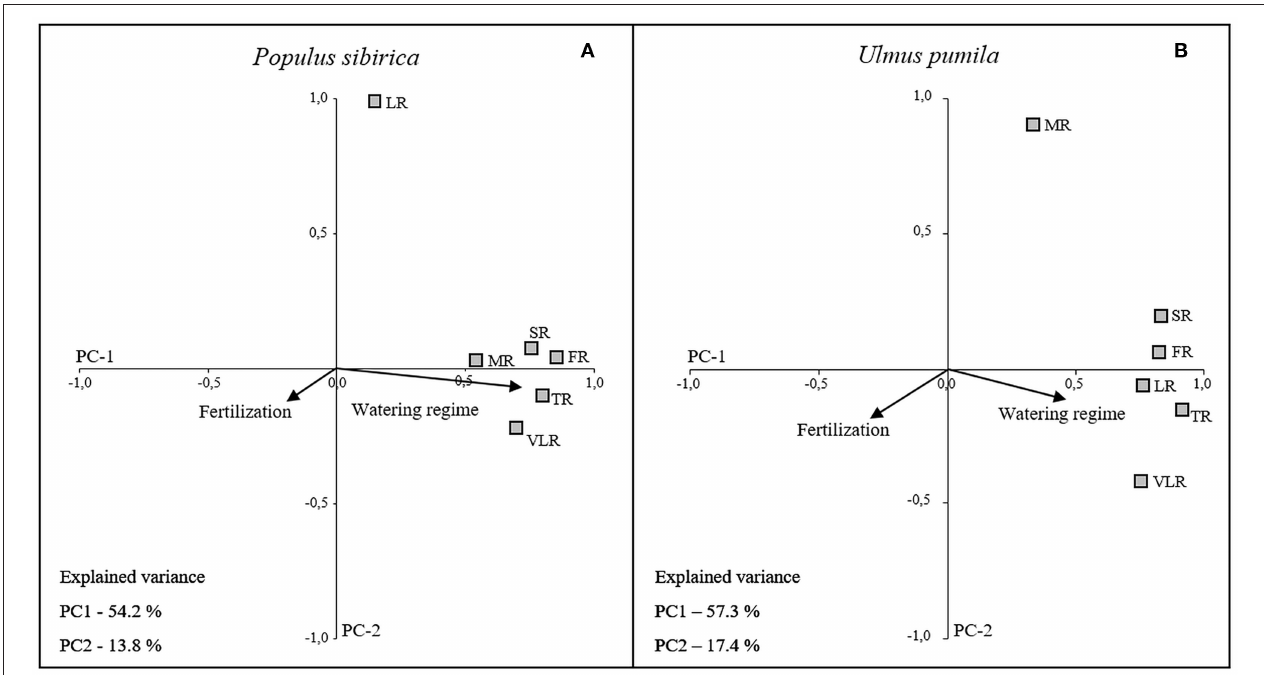
FIGURE 6 | Categorical Principal Component Analysis (CATPCA) biplot of P. sibirica (A) and U. pumila (B) indicating the different root classes biomass projection in relation with watering regime and fertilization. Tightly clustered variables are positively related, while variables at different ends of the figure are negatively related. Arrows represents the mean influence magnitude for each factor.